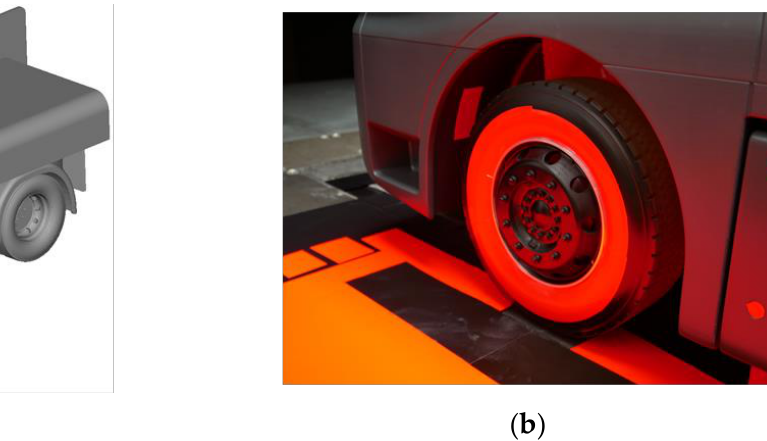
Figure 6. PIV measurements: ( a ) Schematic representation of plane locations where measurements are taken; ( b ) Front wheel with low-reflection setup.